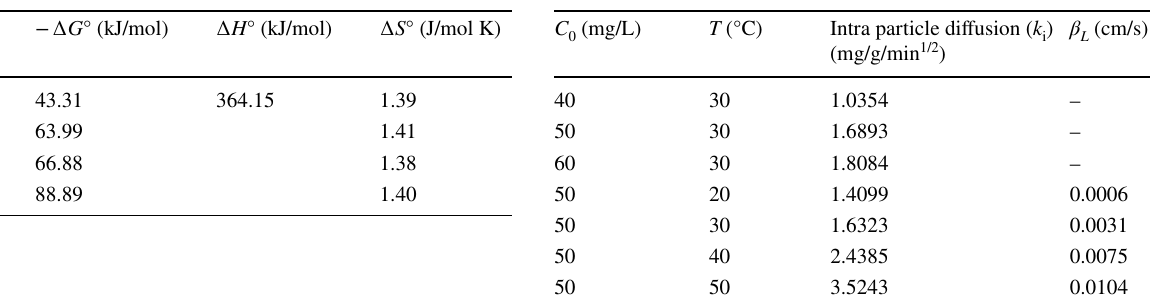
Table 4 Thermodynamic parameters Table 5 Pore diffusion